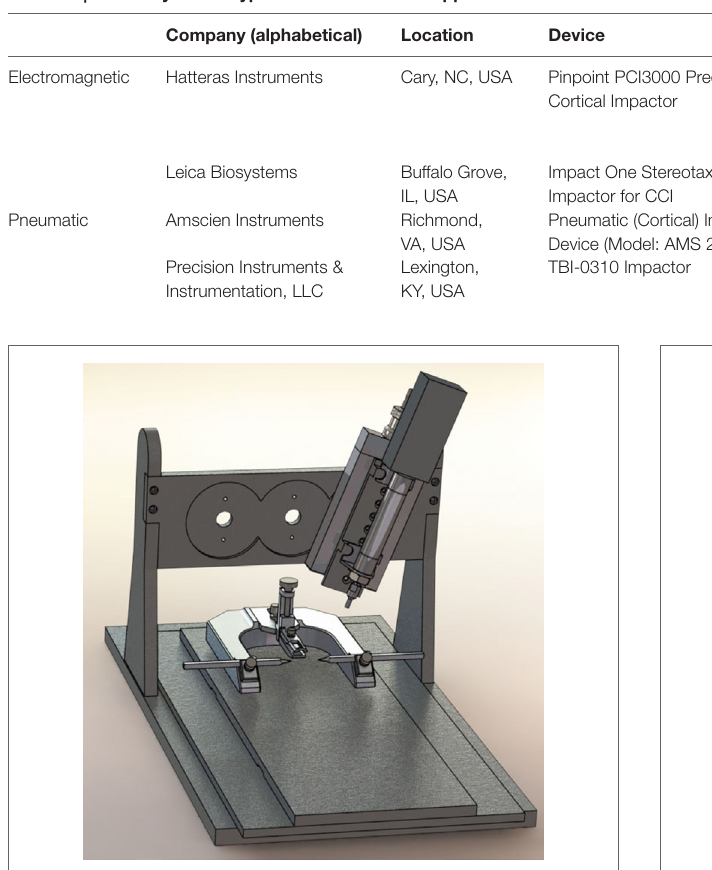
FiGURe 2 | electromagnetic controlled cortical impact device (Leica Biosystems, Buffalo Grove, iL, USA) . FiGURe 1 | Pneumatic controlled cortical impact device (Pittsburgh